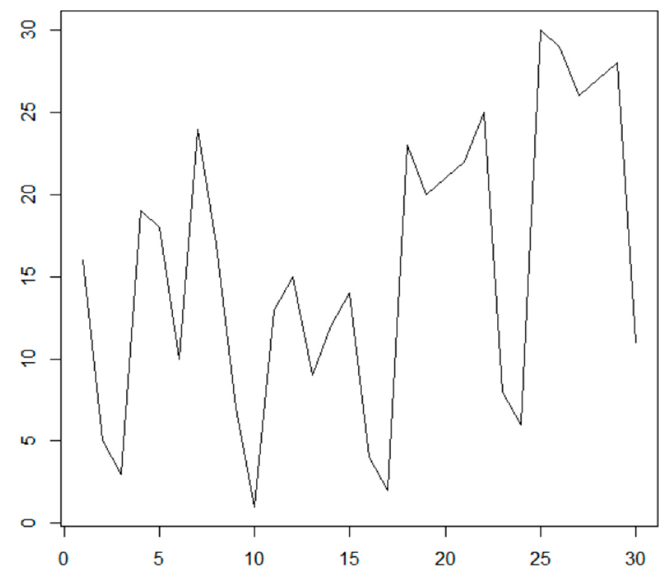
Figure 5. Daily maximum power demand (June 2018).